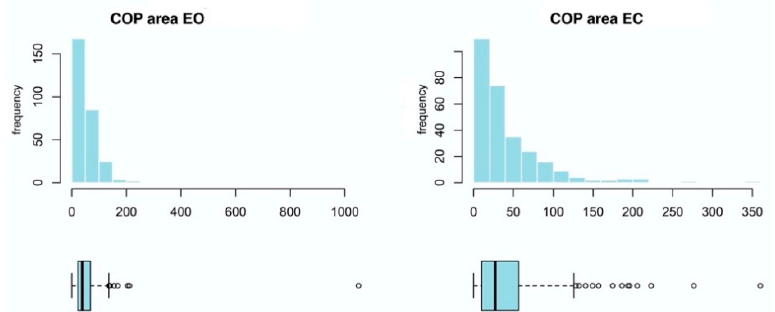
Figure 6. Box plots and histograms for the two-dimensional COP-SA variable. The graphs were constructed from all the data gathered from both groups. COP—center of pressure; EO—eyes open; EC—eyes closed.